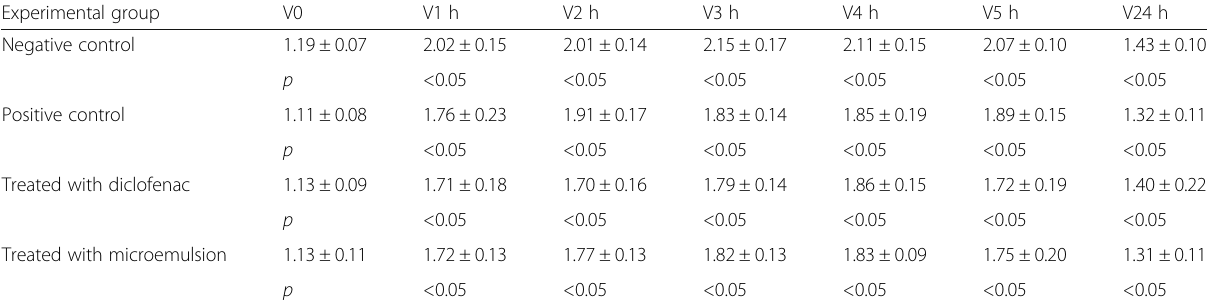
Table 7 The results of the plethysmometric measurement of the paw oedema induced with dextran, including statistical interpretation (V, the volume of oedema, mL; t Test, p) Experimental group